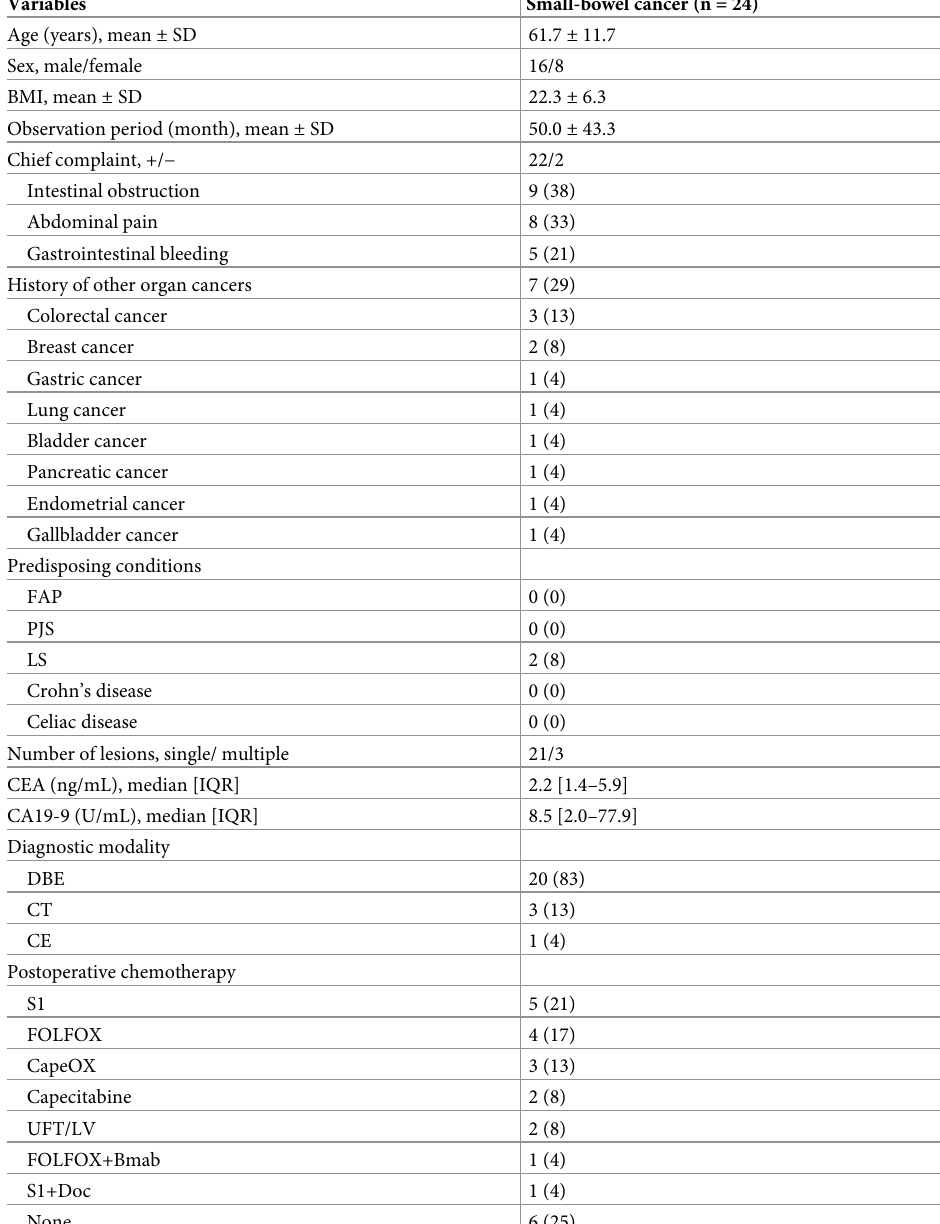
Table 1. Baseline characteristics of small-bowel cancer. Characteristics patients with small-bowel cancer in our